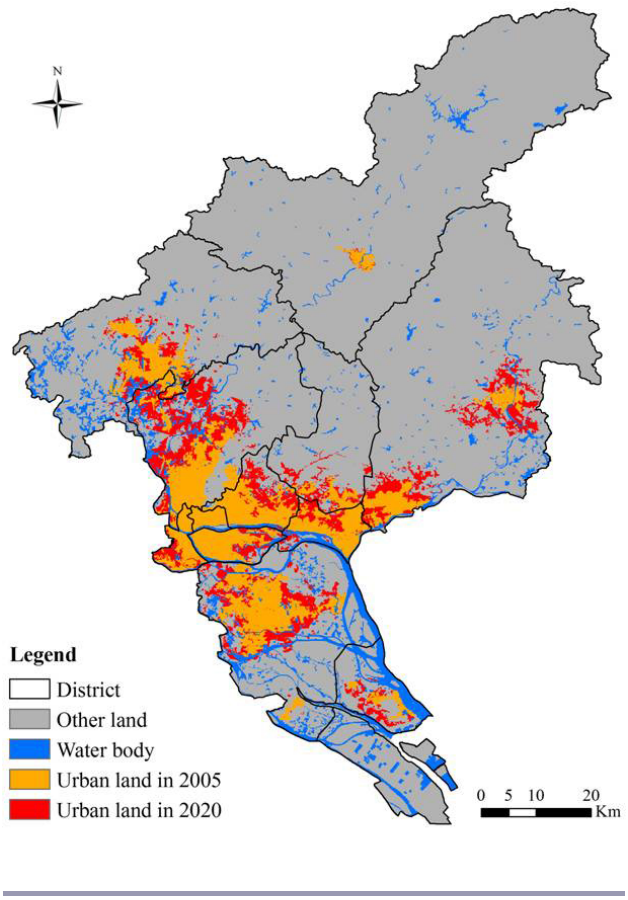
Fig. 4 . The simulation of urban development in Guangzhou metropolitan region in 2020 for baseline